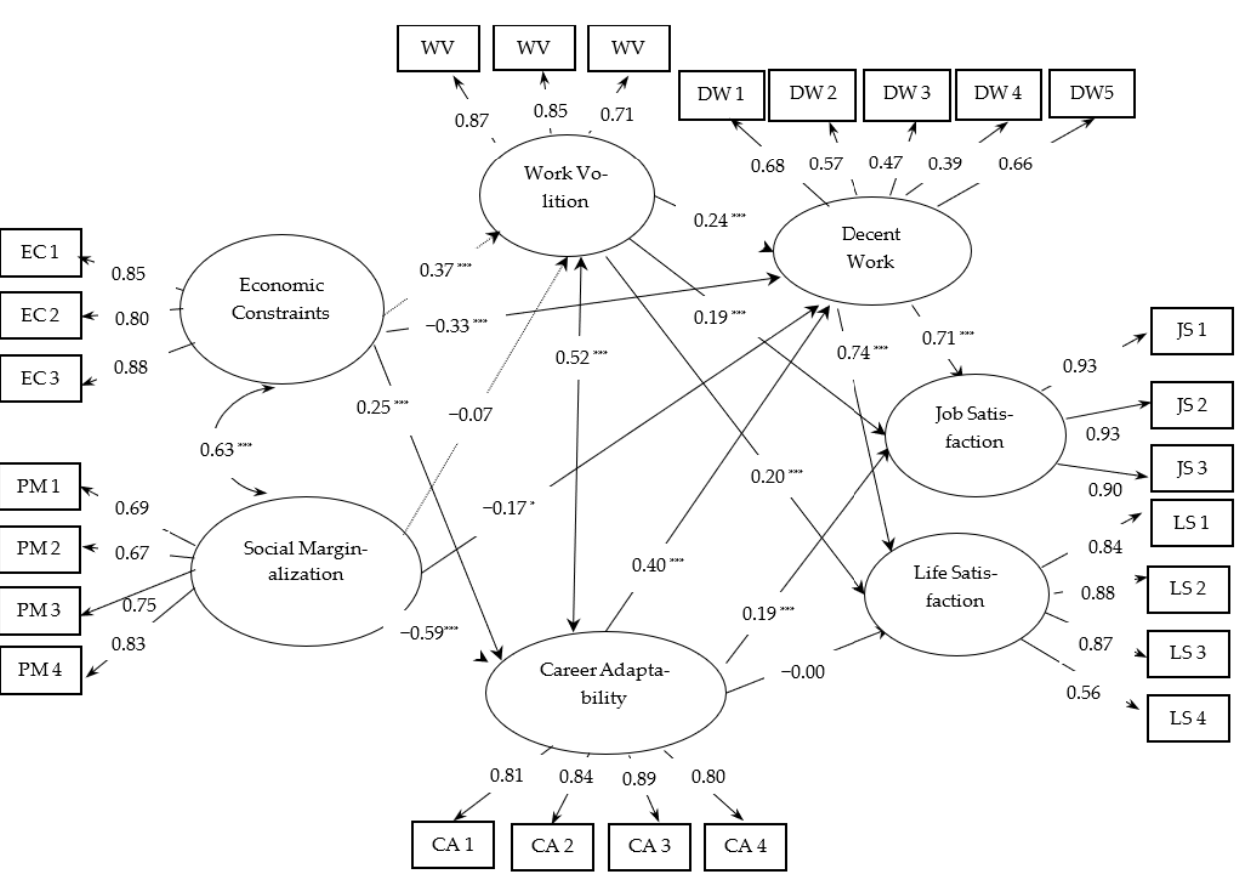
Figure 2. Standardized parameter estimates from the path analysis ( N = 420). EC1–3 = item parceling economic constraints; PM1–4 = 4 items on social marginalization; WV1 = volition; WV2 = financial constraints; WV3 = structural constraints; CA1 = concern; CA2 = control; CA3 = curiosity; CA4 = confidence; DW1 = physically and interpersonally safe working conditions; DW2 = access to healthcare; DW3 = adequate compensation; DW4 = hours that allow for free time and rest; DW5 = organizational values complement family and social values; JS1 = intrinsic; JS2 = extrinsic; JS3 = general satisfaction; LS1–4 = 4 items on life satisfaction. Solid lines: significant paths, dashed line: nonsignificant paths. * p < 0.05; *** p < 0.001.